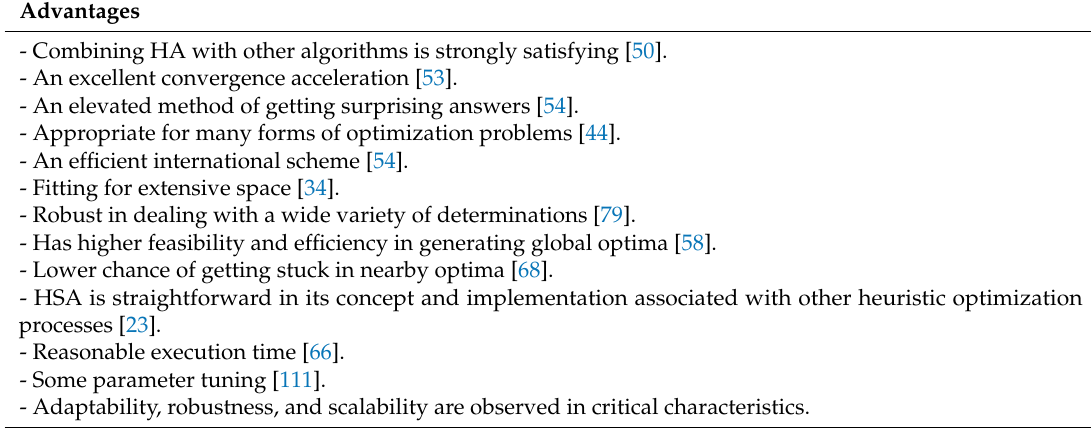
Table 3. Advantages and disadvantages of